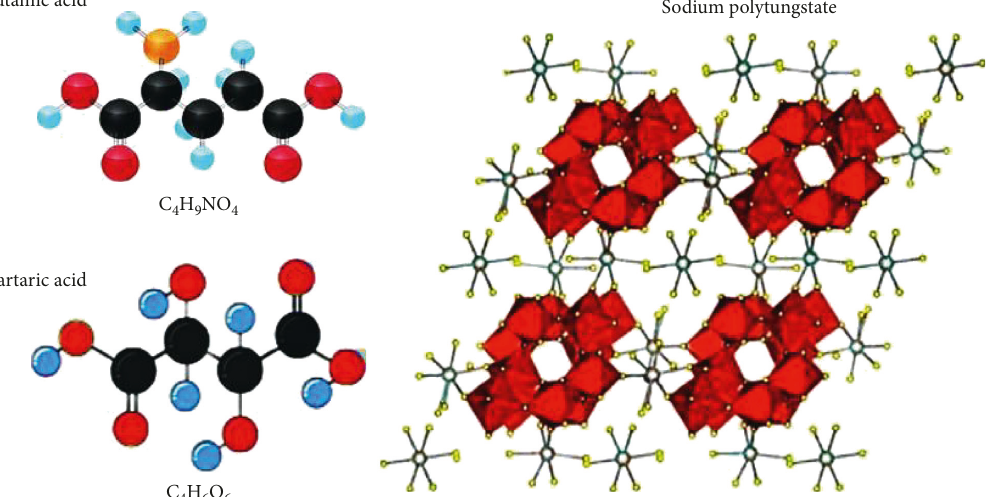
Figure 3: Chemical structure of glutamic acid, tartaric acid, and synthesized sodium